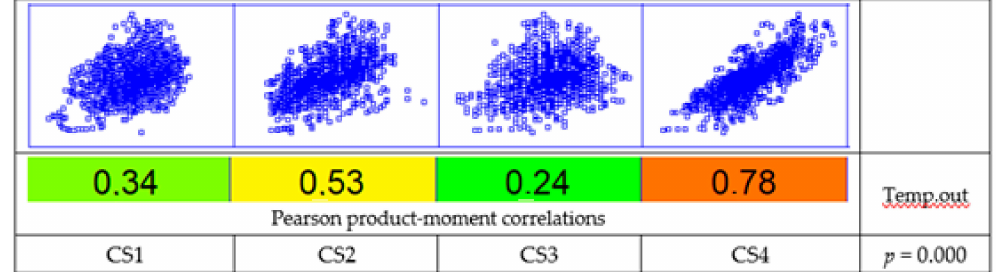
Figure 8. Pearson product-moment correlations in the Madrid case